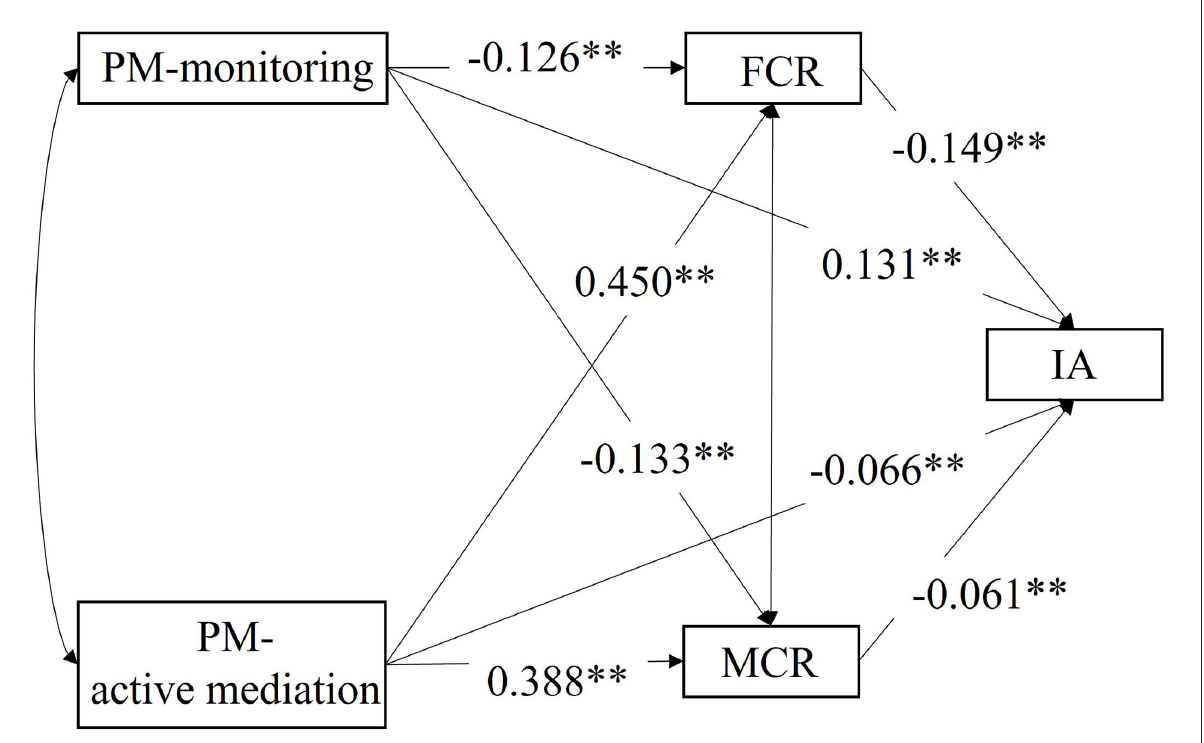
FIGURE2 The SEM is investigating how FCR and MCR mediate the effect of PM on IA level. ** p <